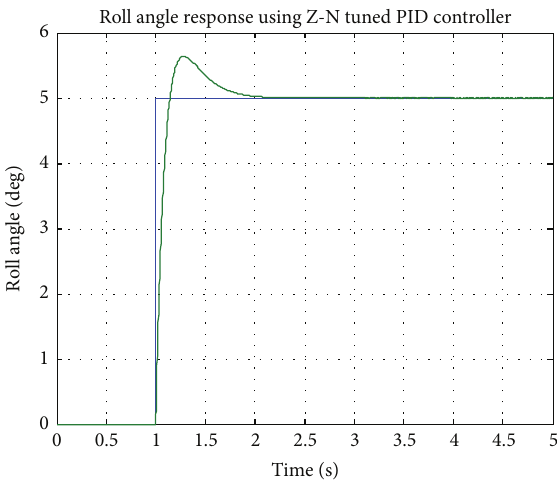
Figure 2: 𝜙 versus 𝑎 𝑦 error transient response for Z-N PID controller.